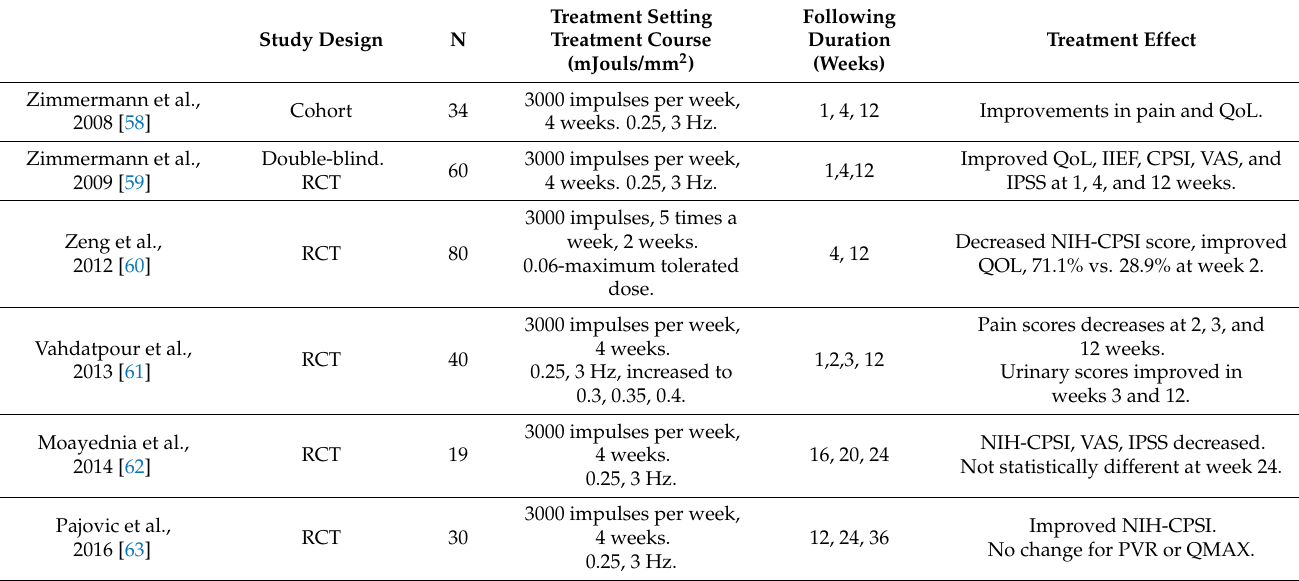
Table 1. LESW for chronic prostatitis/chronic pelvic pain